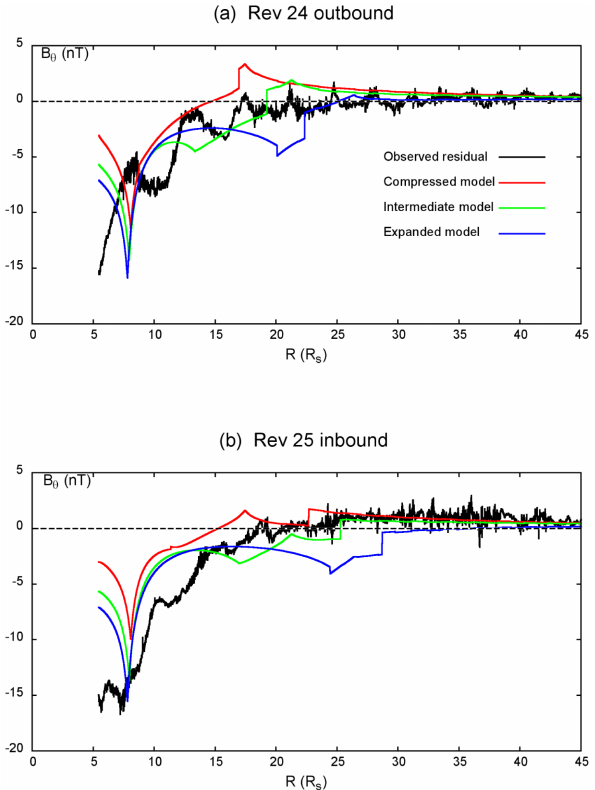
Figure 7. Plots showing the residual co-latitudinal field B θ versus radial distance R ( R S ) together with paraboloid model results for (a) Rev 24 outbound, and (b) Rev 25 inbound. Model results are shown by the red, green, and blue lines for the compressed, inter- mediate, and expanded linear approximation models, respectively, whose parameters are given in Table